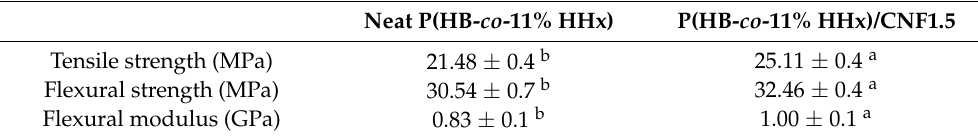
Table 6. Mechanical properties of neat P(HB- co -11% HHx) and P(HB-co-11% HHx)/CNF1.5 bio-